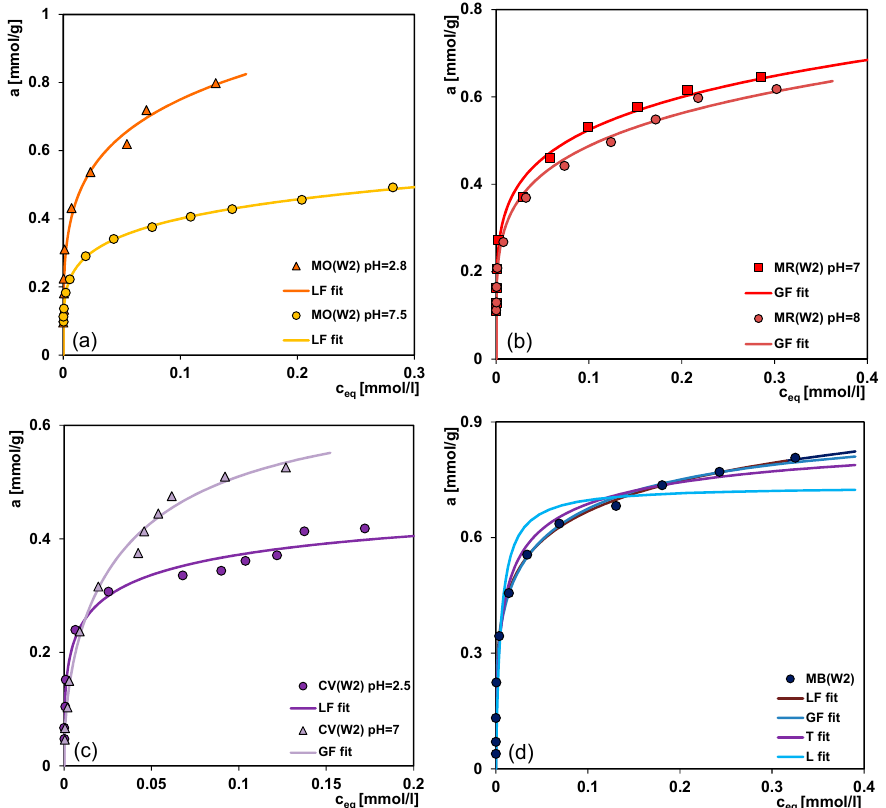
Figure 8. Effect of initial solution pH on methyl orange ( a ); methyl red ( b ) and crystal violet ( c ) adsorption on the W2 carbon. Comparison of isotherms of methylene blue on the W2 carbon fitted by various variants of the Generalized Langmuir (GL) equation ( d ).